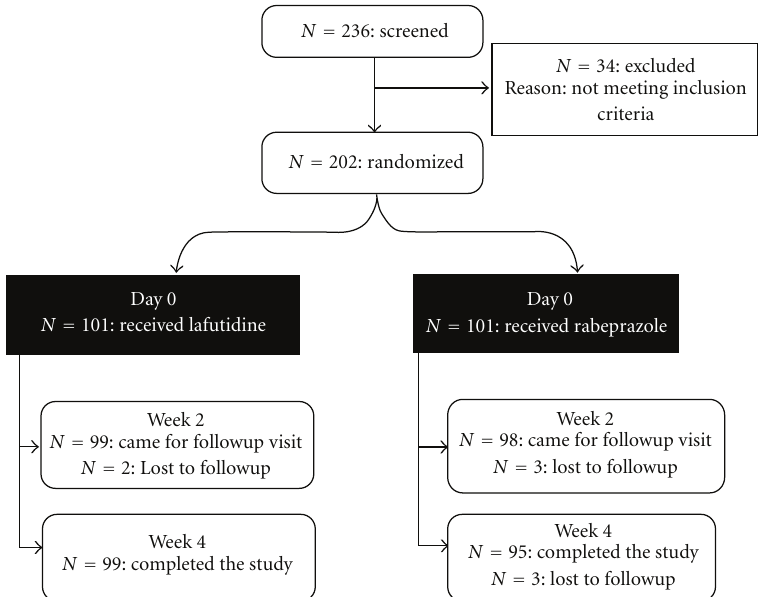
Figure 1: CONSORT flow diagram showing the number of patients enrolled in the study randomized to each treatment group and reasons for